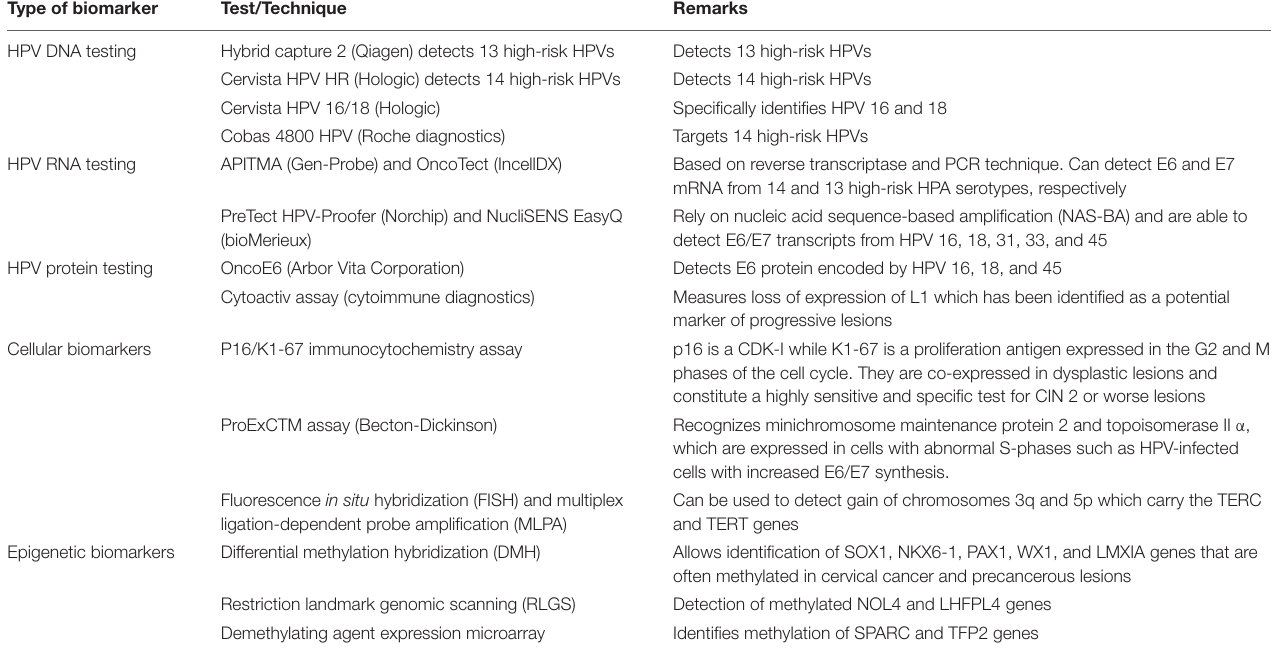
TABLE 2 | HPV infection